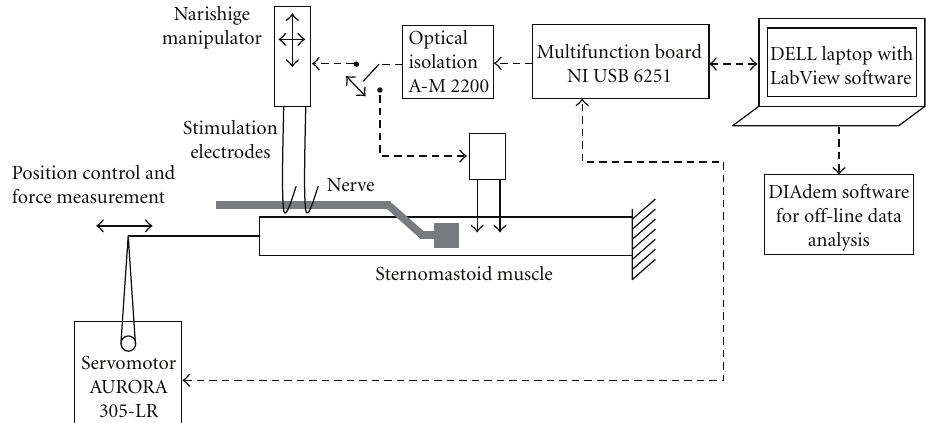
Figure 2: The schematic for the stimulation and recording system. The SM muscle is illustrated in the center. An Aurora Servomotor unit (305-LR) was used to stretch the SM muscle to optimal length and record muscle force. Electrical stimulation (200 ms trains of 200 Hz biphasic pulses) was generated by a National Instruments multifunction board (NI USB 6251). The stimulation trains were optically isolated from ground with an Optical Isolation Unit (A-M 2200) and directed to the SM nerve or directly to SM muscle. A Dell laptop with user- written LabView software was used to control the output signals (intensity of electrical stimulation and position of the servomotor lever) and to record the input signal (muscle force). Data were analyzed o ffl ine with National Instruments DIAdem